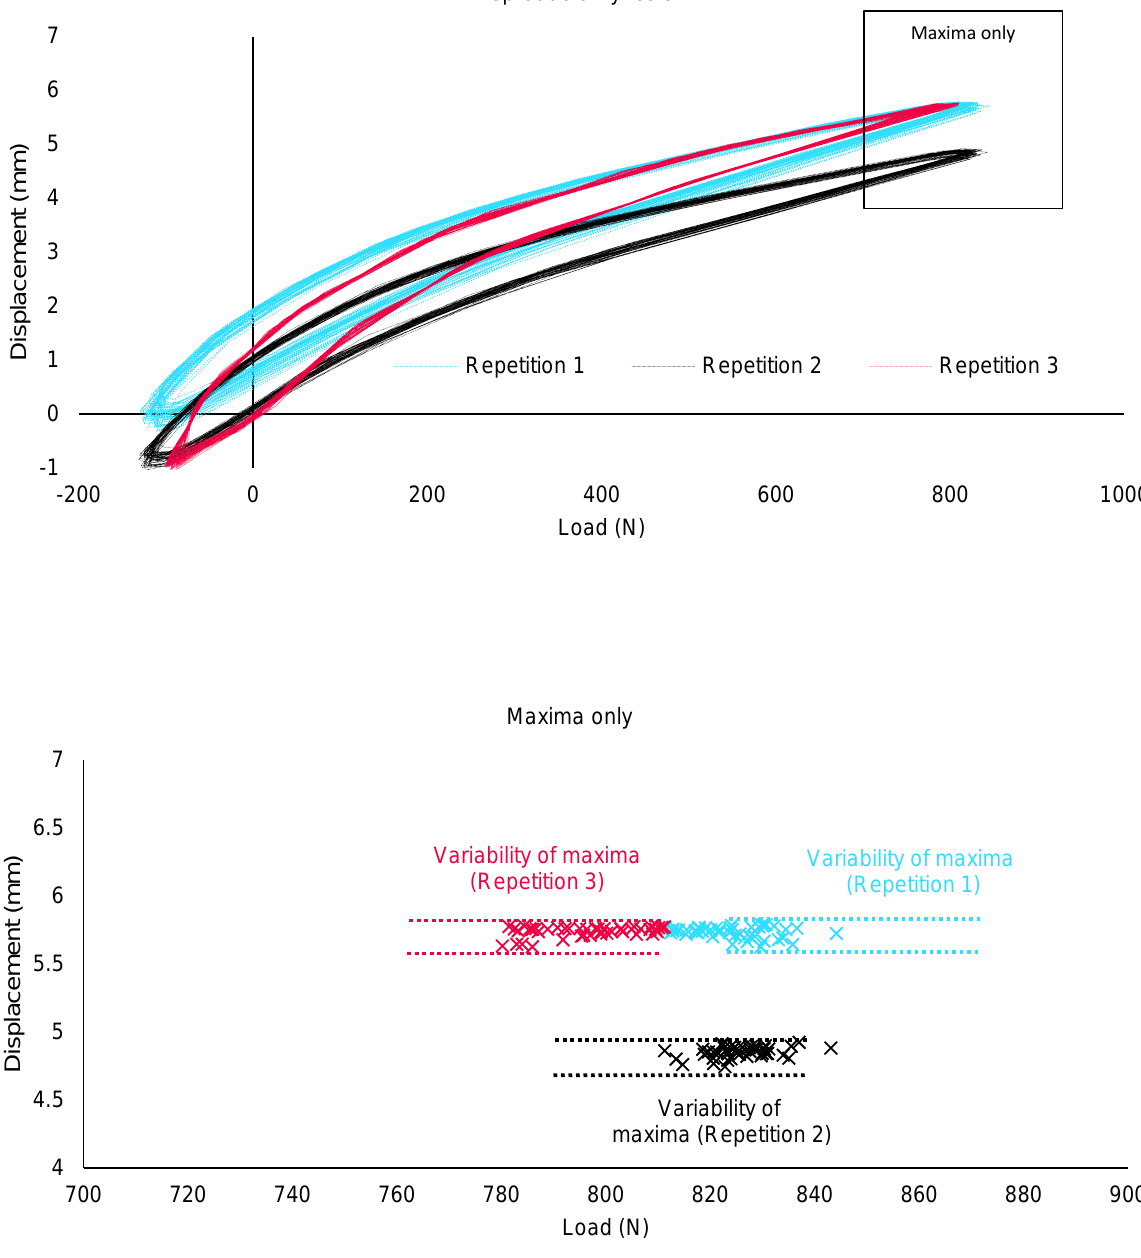
Figure 2: (Top) The displacement v load curves for the three reproducibility tests. Positive load and displacement indicate compression, negative load and displacement indicate tension. N.B. Not all curves pass through the origin due to the exclusion of the first five cycles. (Bottom) The maximum displacements of each of the cycles, for each reproducibility test. The variability of these maxima, within each test, is